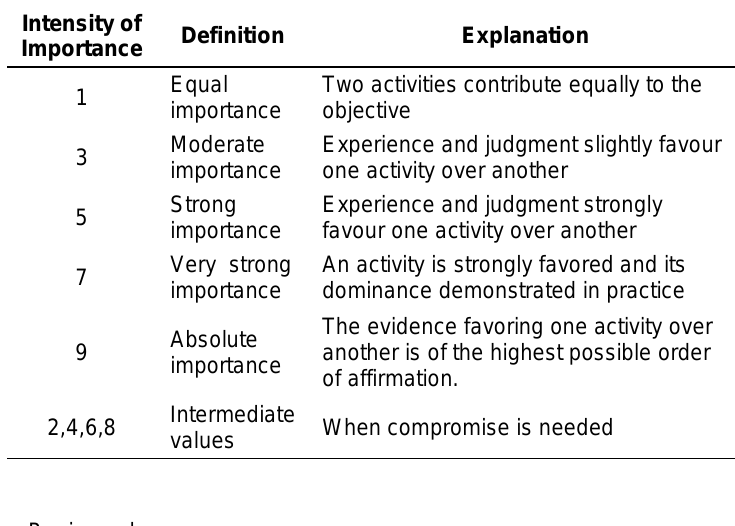
Table 1. The Saaty's 9-points rating scale Source: Saaty (1996)